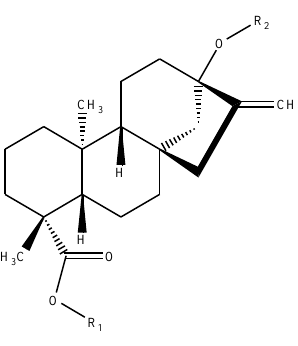
Figure 1. Backbone figure of Stevia sweeteners.